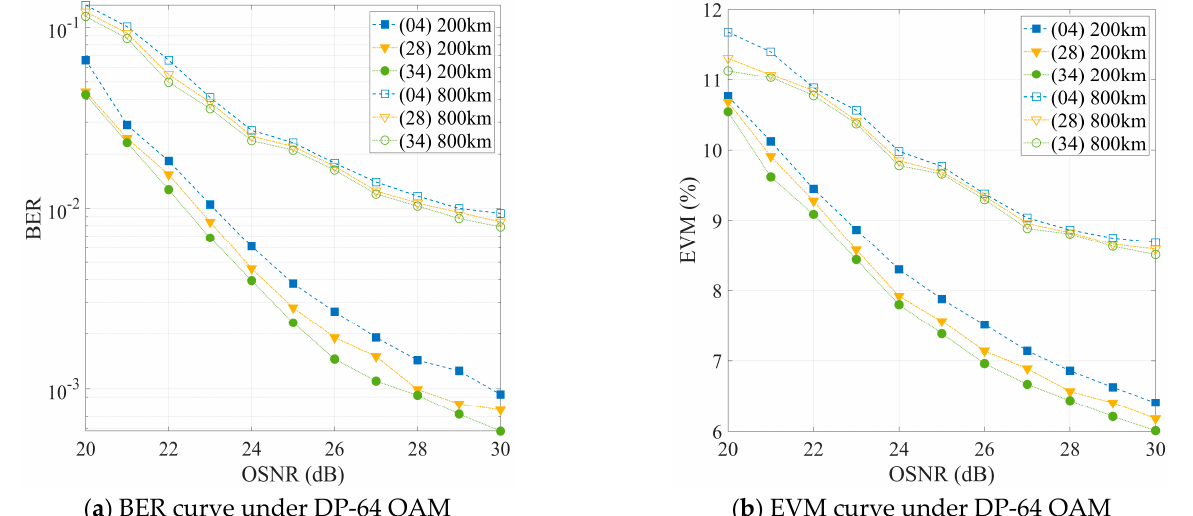
Figure 5. The BER and EVM performance of the DP-64 QAM data. We compare the equalization performance of the filters of TD-CDE-FIR, SVDLS-FIR, and AMPSO-FIR under different OSNR when the same filter length n and the transmission distance are 200 km and 800 km. ( a ) Performance index of BER; ( b ) Performance index of EVM.